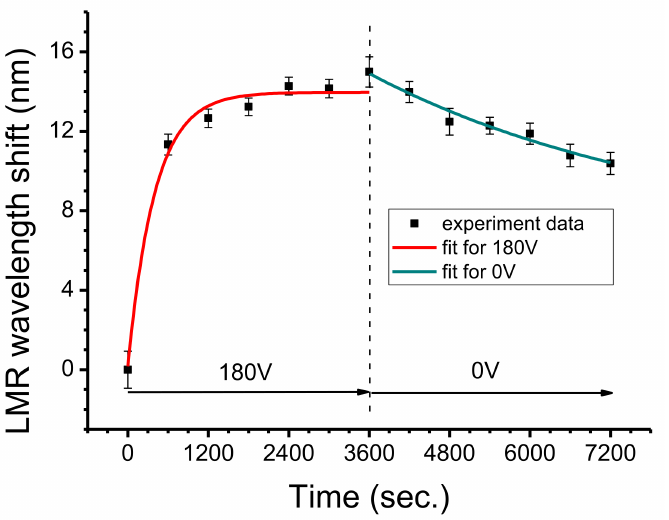
Figure 6. LMR wavelength shift of 1% BSA for an applied voltage 180 V for 3600 s and with no applied voltage for another 3600